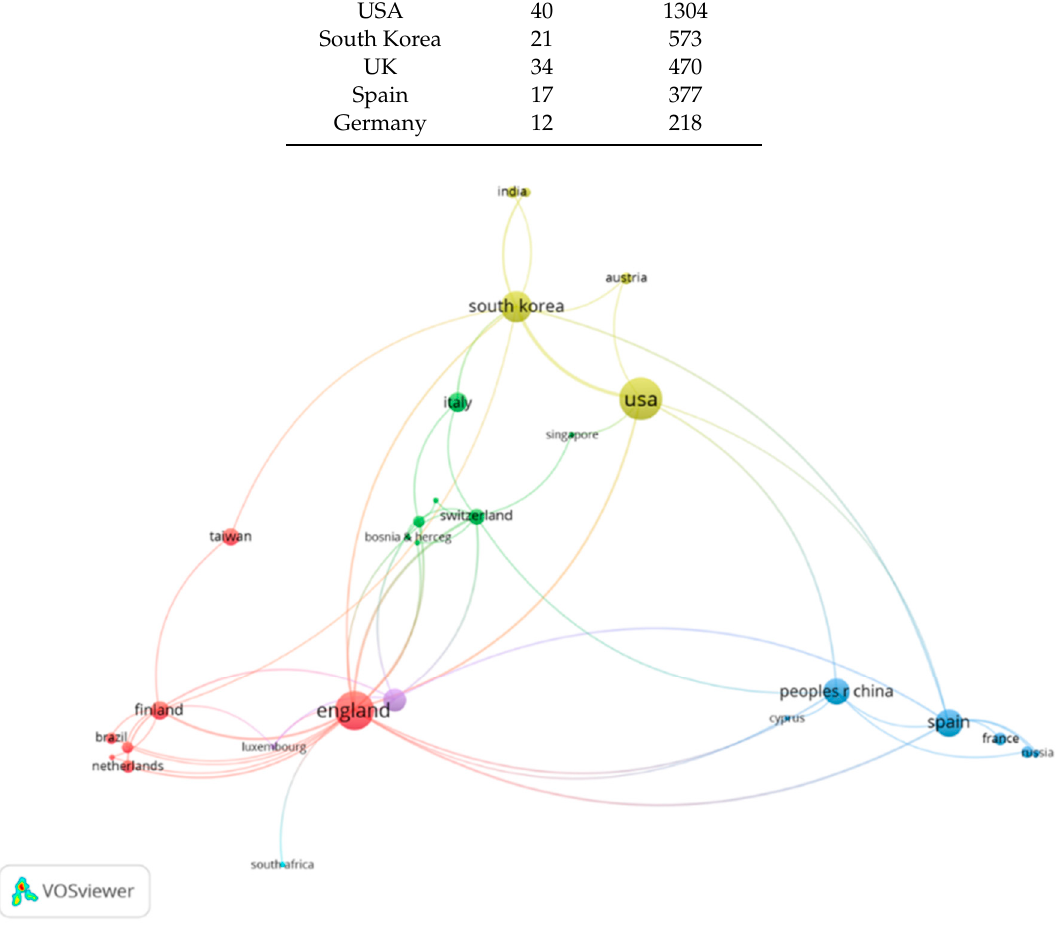
Figure 4. Mapping of most productive countries. Source: Own elaboration based on VOSviewer.